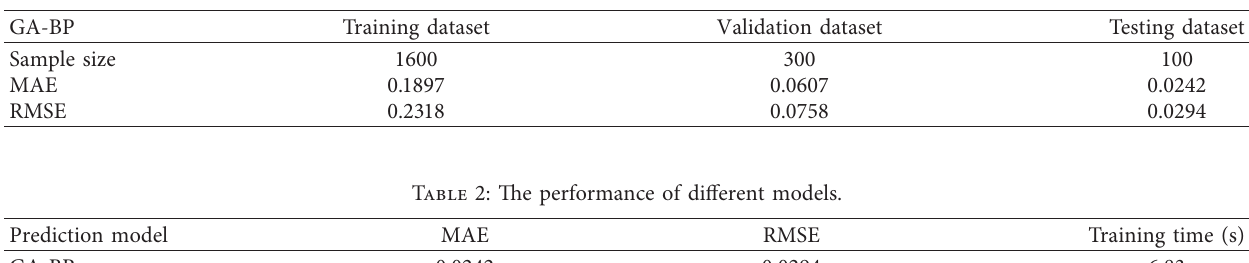
Figure 4: Prediction error of different models on System I. Table 1: Design specifications of GA-BP neural network model.